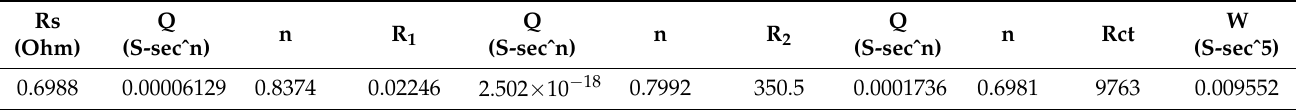
Table 2. Fitted impedance values of 36 wt% H 2 SO 4 (E).